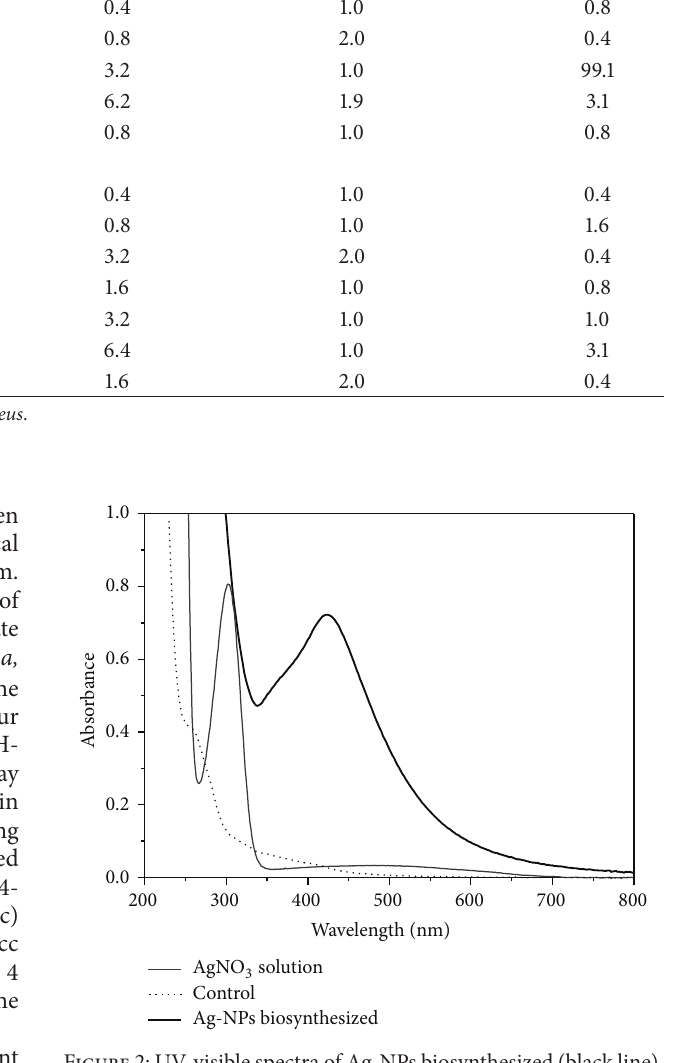
Figure 2: UV-visible spectra of Ag-NPs biosynthesized (black line), AgNO 3 solution (gray line), and P. aeruginosa culture supernatant (control, dotted line). The absorption of Ag-NPs was recorded after the addition of a culture supernatant of P. aeruginosa at 30% by volumeto10 mMAgNO 3 solution.Thecurvewasrecordedafter24 h of